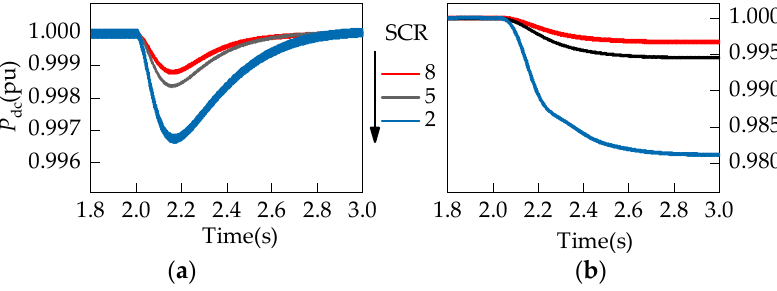
Figure 7 . DC power under different short-circuit ratios (SCRs): ( a ) LOE fault on the rectifier side; ( b ) Figure 7. DC power under di ff erent short-circuit ratios (SCRs): ( a ) LOE fault on the rectifier side; LOE fault on the inverter side. ( b ) LOE fault on the inverter